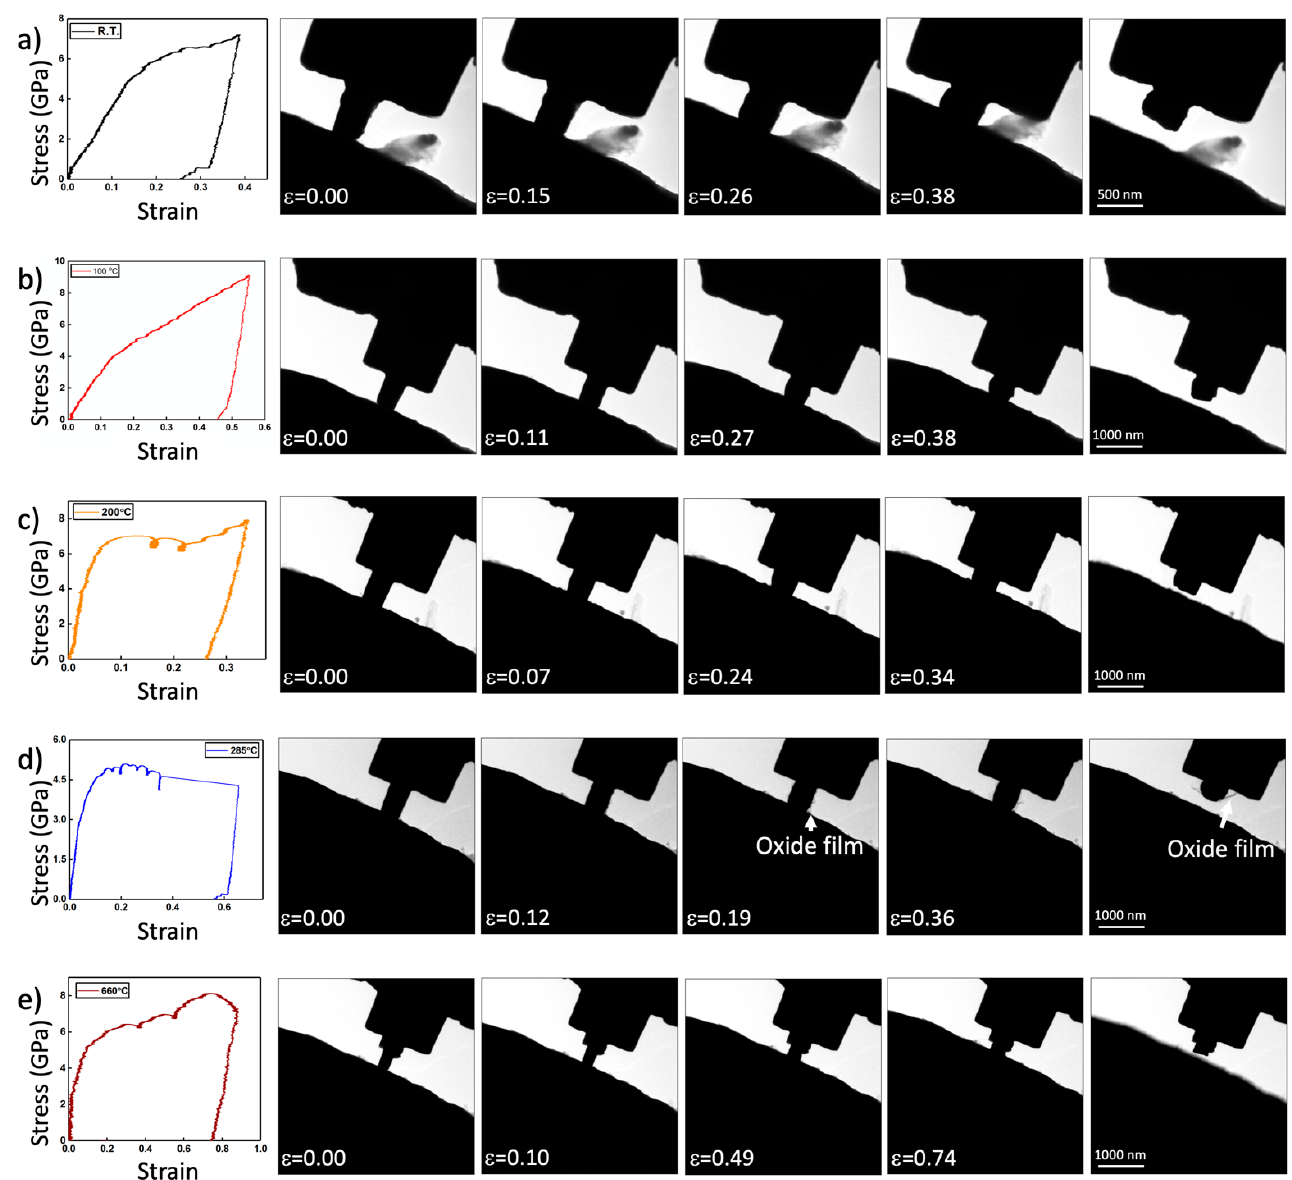
Figure 2. A series of nanopillar compression experiments performed at ( a ) room temperature, ( b ) 100 ◦ C, ( c ) 200 ◦ C, ( d ) 285 ◦ C, and ( e ) 660 ◦ C. including time-lapse images and stress–strain curves. Of note is the observation of a thin scale debonding from the tungsten pillar while testing at 285 °C.